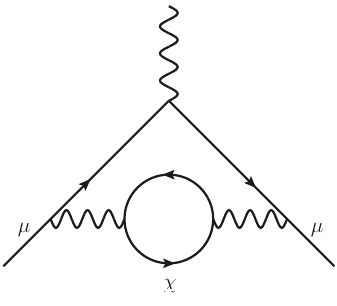
Figure 1 . The two-loop contribution to muon g − 2 from millicharged particles χ contributions to the photon vacuum